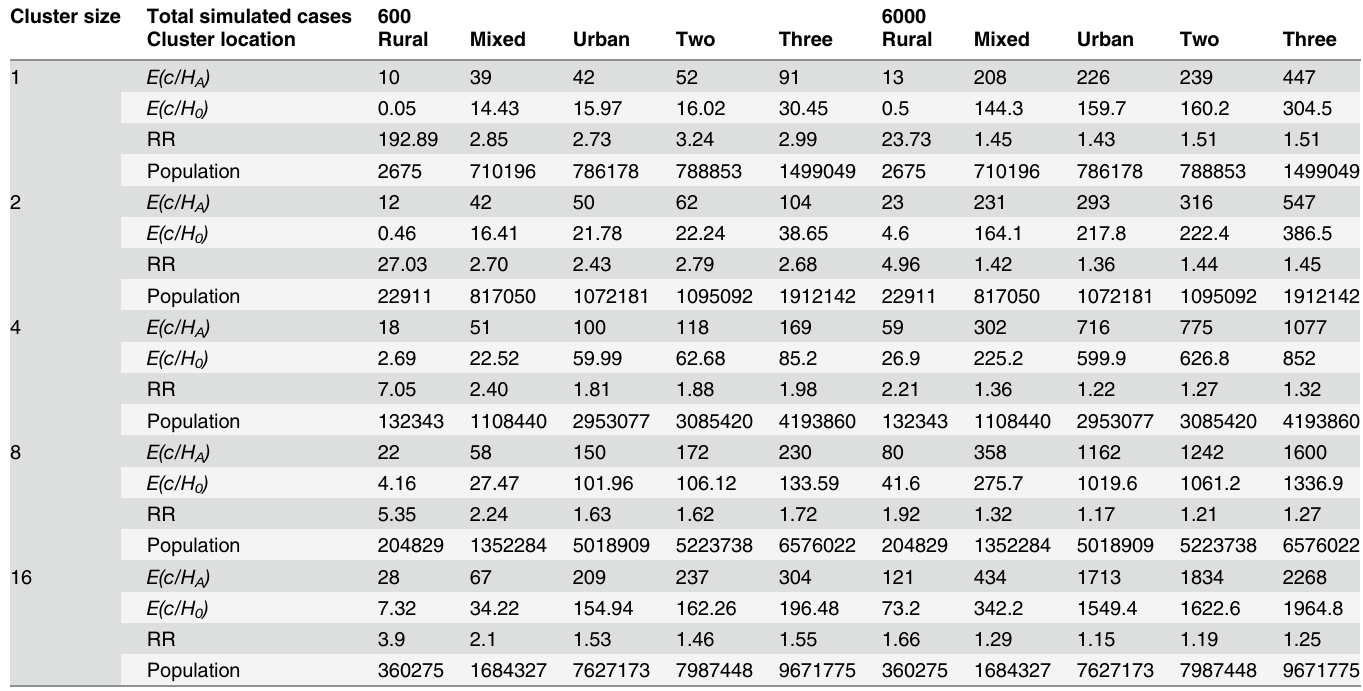
Table 1. Simulated cluster